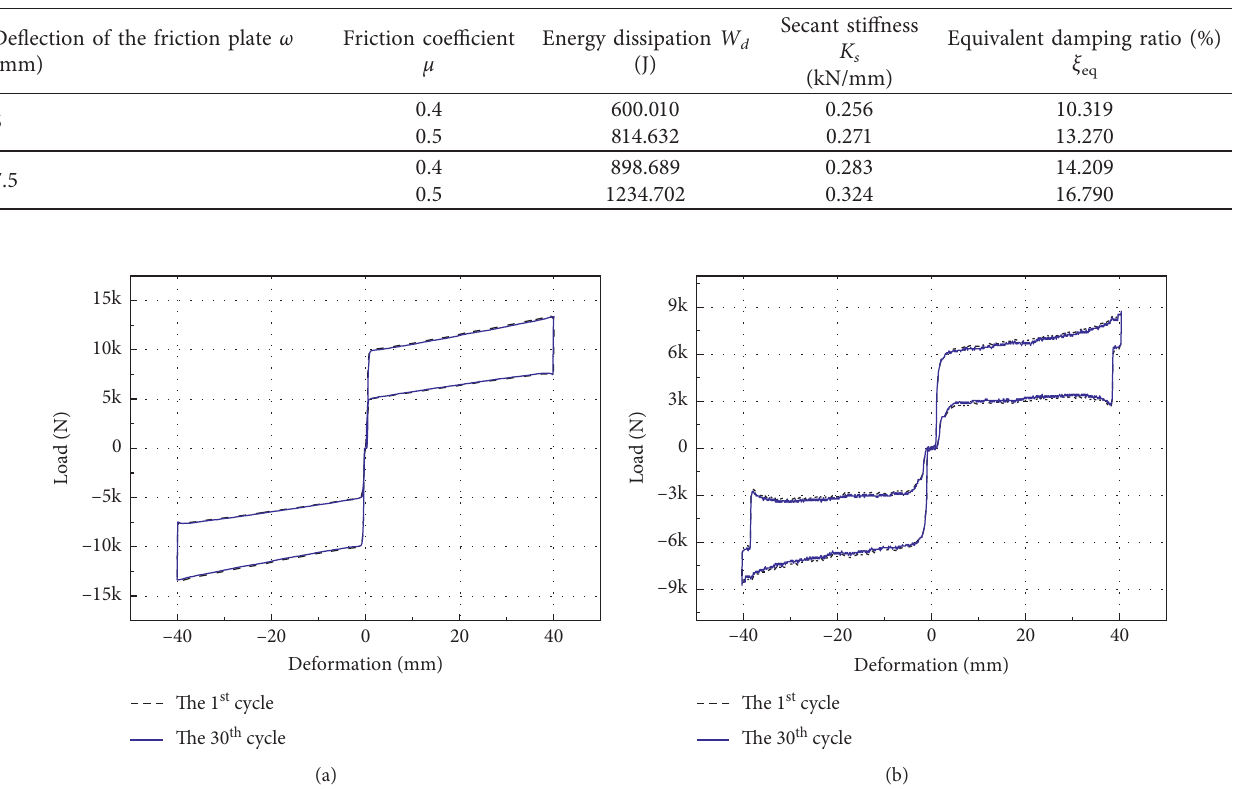
Table 8: Mechanical parameters under different friction coefficients.